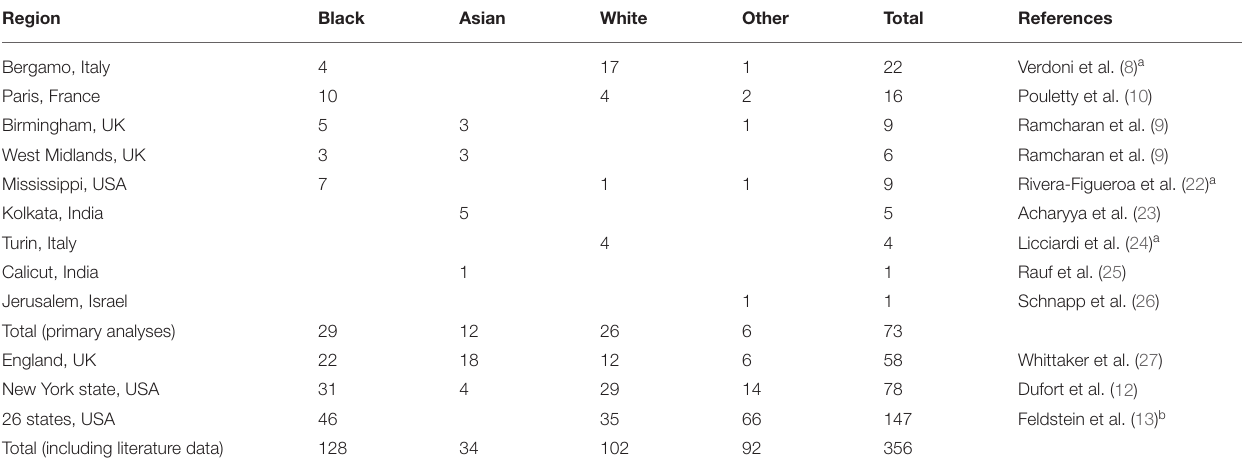
TABLE 1 | Numbers of reported cases by participating center. Region